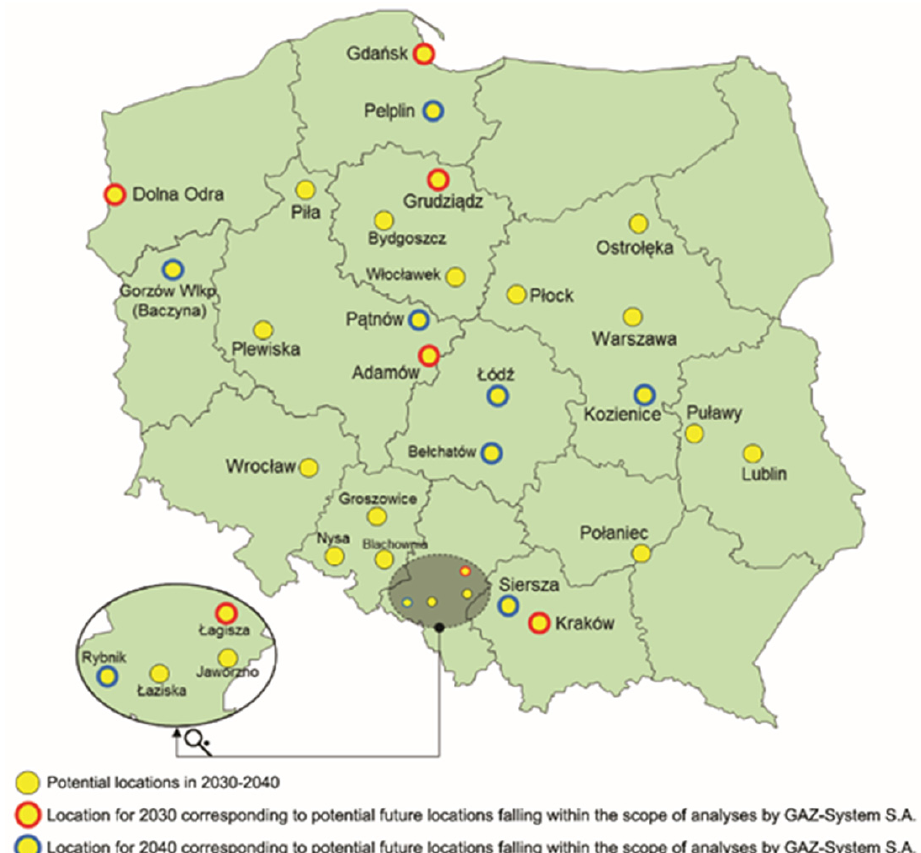
Figure 2. Potential locations for new natural gas-fired generating units in the period up to 2040. Source: PSE SA, 6/2020 r., Development plan for meeting current and future electricity demand for period 2021–2030 [26].